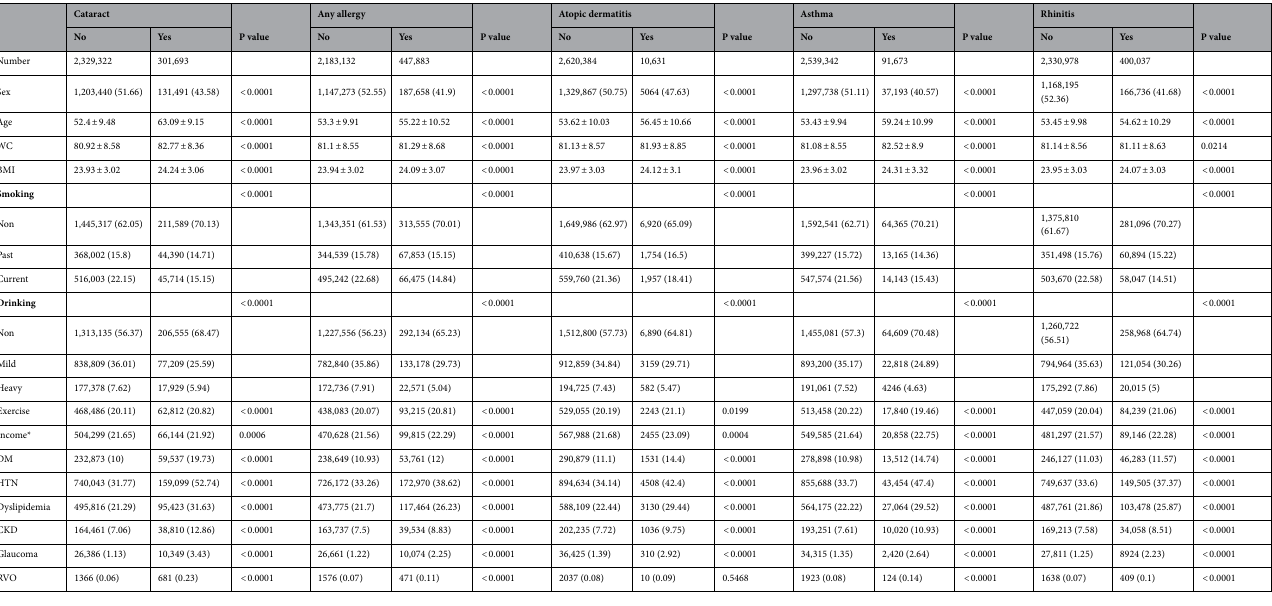
Table 1. General characteristics of study population. WC, waist circumstance; BMI, body mass index; DM, diabetes mellitus; HTN, hypertension; CKD, chronic kidney disease; RVO, retinal vascular occlusion. *Low income indicates the low quadrant of income level